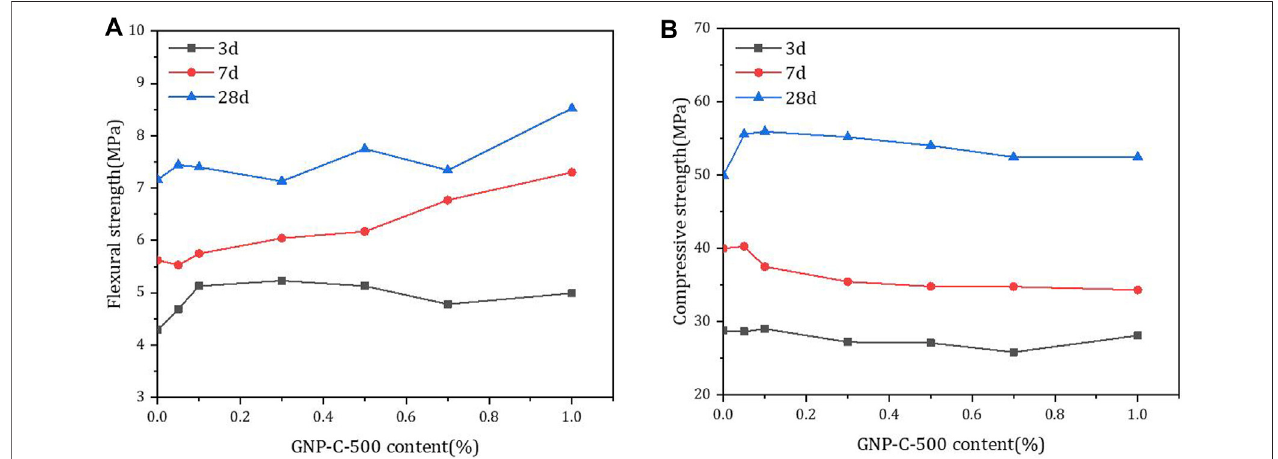
FIGURE 7 | The effects of curing age and the GNP-C-500 content on (A) fl exural strength and (B) compress strength.